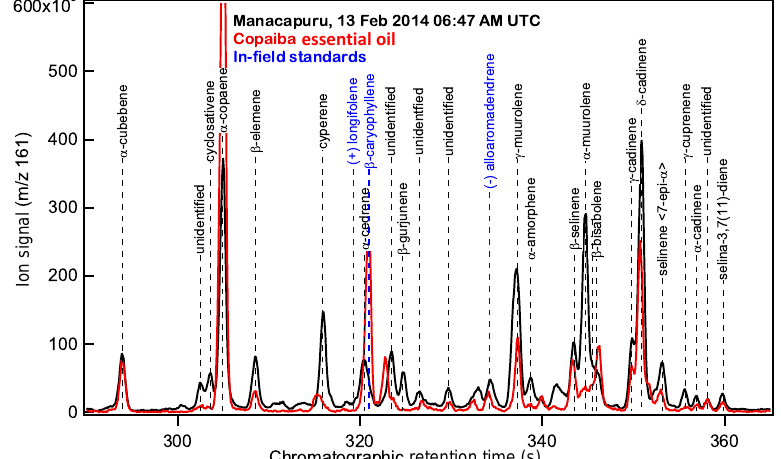
Figure 1. Selected ion chromatograms at sesquiterpene characteristic ion m/z 161 of ambient air (black) and copaiba essential oil (red). Sesquiterpenes in ambient air were measured in the gas phase. Copaiba essential oil was analyzed from direct liquid injection on SV-TAG collection cells. Retention times for standards analyzed in the field are indicated in